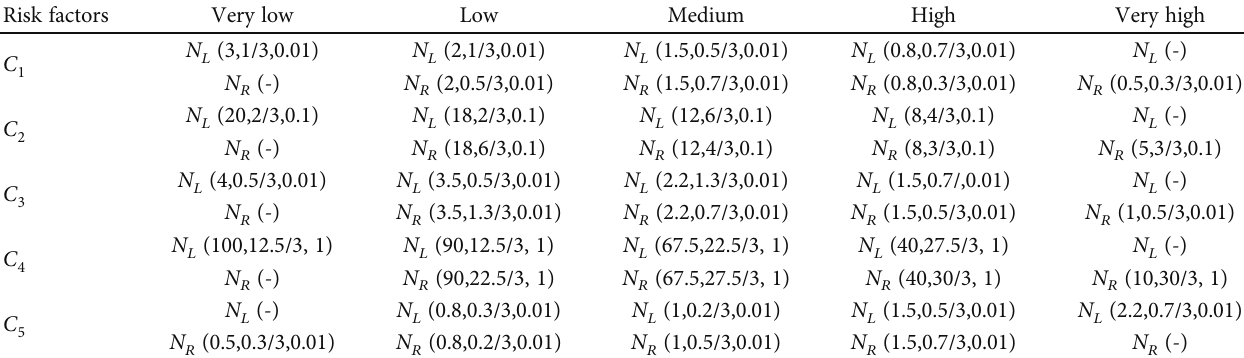
Table 3: Grade standard and grey cloud whitening weight model for CRI of crossing situation.